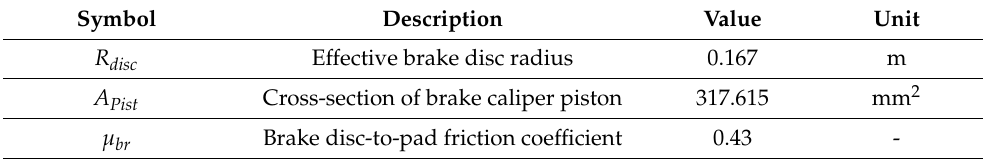
Figure 1. Simplified hydraulic scheme of the hybrid brake-by-wire system used. Table 1. Main parameters of the brake-by-wire system used.